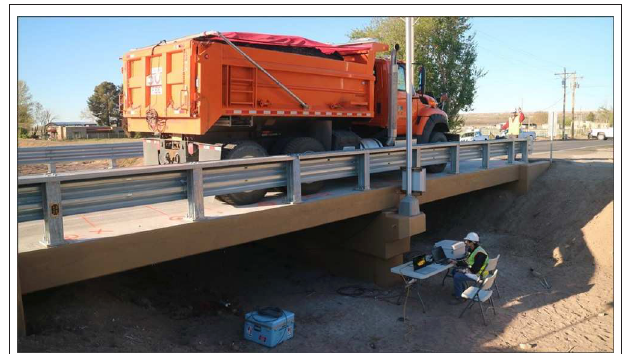
FIGURE 5 | Single truck moving on the bridge.